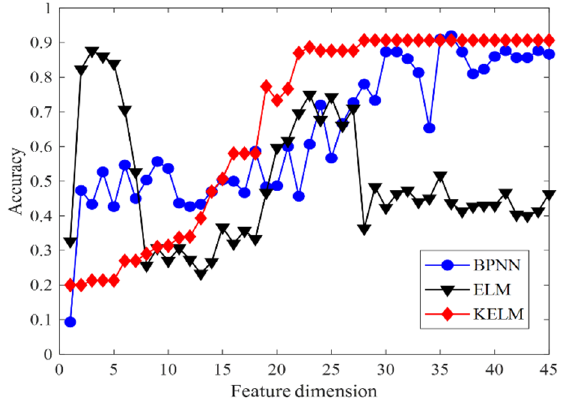
Figure 16. Diagnostic accuracy obtained with KPLS dimensionality reduction features.